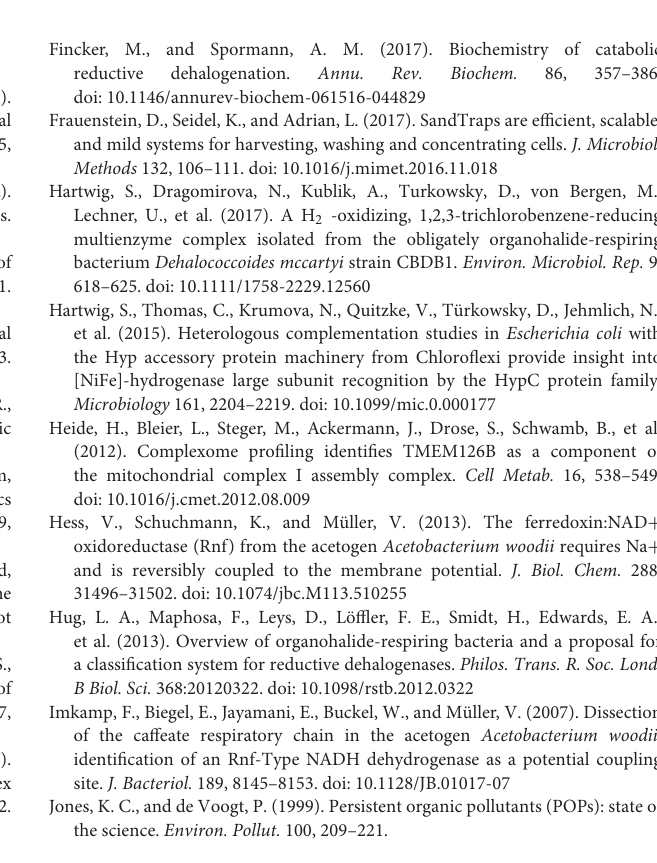
Supplemental Figure 1 | Analysis of single peptide distributions across the native gel lane together with the respective proteins. (A) HupL, (B) OmeA, (C) RdhA CbdbA84. Splitting of peak maxima was observed in OmeA and CbdbA84. Supplemental Figure 2 | Hierarchical cluster analysis of the distribution across a blue native gel for all peptides of the OHR complex after extraction mode 3. The analysis indicates that peptides originating from the same protein mostly cluster together confirming the stability of our analyses. The three peptides that are isolated on the top were detected only once in a single slice each, explaining their separation in the tree. The color code is the same as elsewhere in this study, with exception of RdhA proteins. RdhA proteins are colored as following: CbdbA80, red, CbdbA84, purple, CbdbA1588, black, CbdbA1618, dark red, and CbdbA1638, bright red. Supplemental Figure 3 | Cluster analysis of all detected proteins in the three complexome analyses. (A) after extraction mode 1; (B) extraction mode 2; (C) extraction mode 3. OHR-complex proteins and ATPase subunits are colorized as elsewhere in this study. Supplemental Table 1 | List of all detected proteins and their identified peptides. The list gives absolute numbers of area counts determined by label-free quantification. The numbers represent the sum of all area count values obtained from the gel slices. Also the number of peptides identified for each protein is listed. Supplemental Table 2 | Color code for the suspected OHR complex proteins used in this